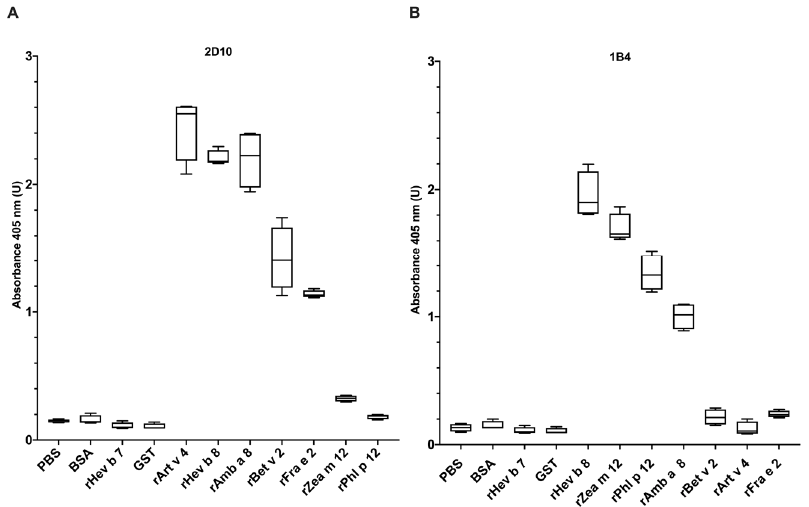
Figure 1. mAbs 2D10 and 1B4 (anti-rHev b 8) binding toward recombinant allergenic profilins rArt v 4, rAmb a 8, rBet v 2, rPhl p 12, rFra e 2, rZea m 12 and rHev b 8. The box and whisker plot shows the binding measured by indirect ELISA and represents the mean and the standard deviation of three experiments. ( A ) mAb 2D10 shows binding with rArt v 4, rHev b 8, rAmb a 8, rBet v 2, and rFra e 2. ( B ) mAb 1B4 shows binding with rHev b 8, rZea m 12, rPhl p 12, and rAmb a 8. The negative controls are BSA, rHev b 7 (patatin), glutathione S-transferase (GST) from Tenia solium and PBS as background control, and the positive control is rHev b 8.